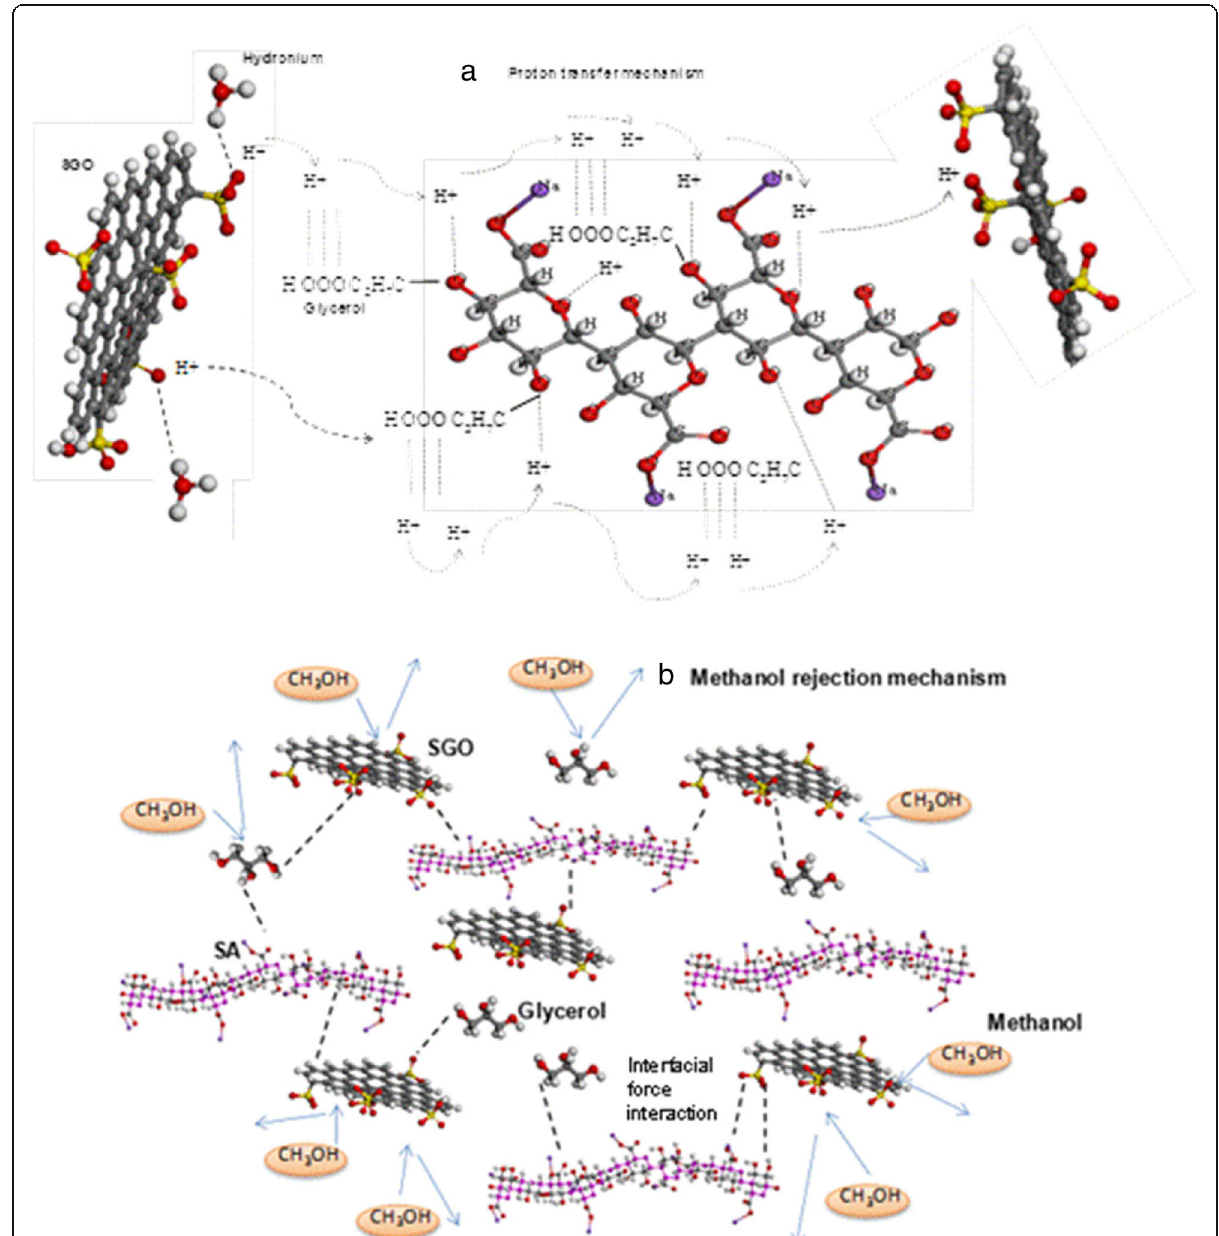
Fig. 13 Suggested mechanism of a proton mobility and b methanol